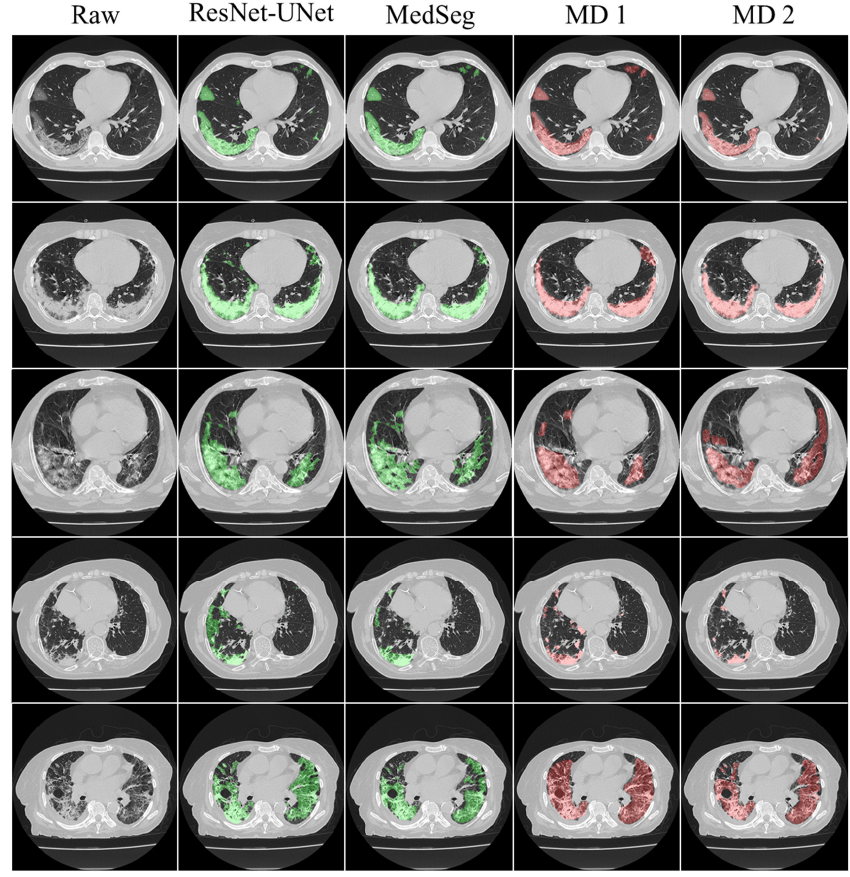
Figure 18. Lesions detected by the best AI model (ResNet ‐ UNet) vs. MedSeg vs. MD 1 vs. MD 2. Table 1. Dice similarity coefficient and Jaccard index when computed against MedSeg. MD